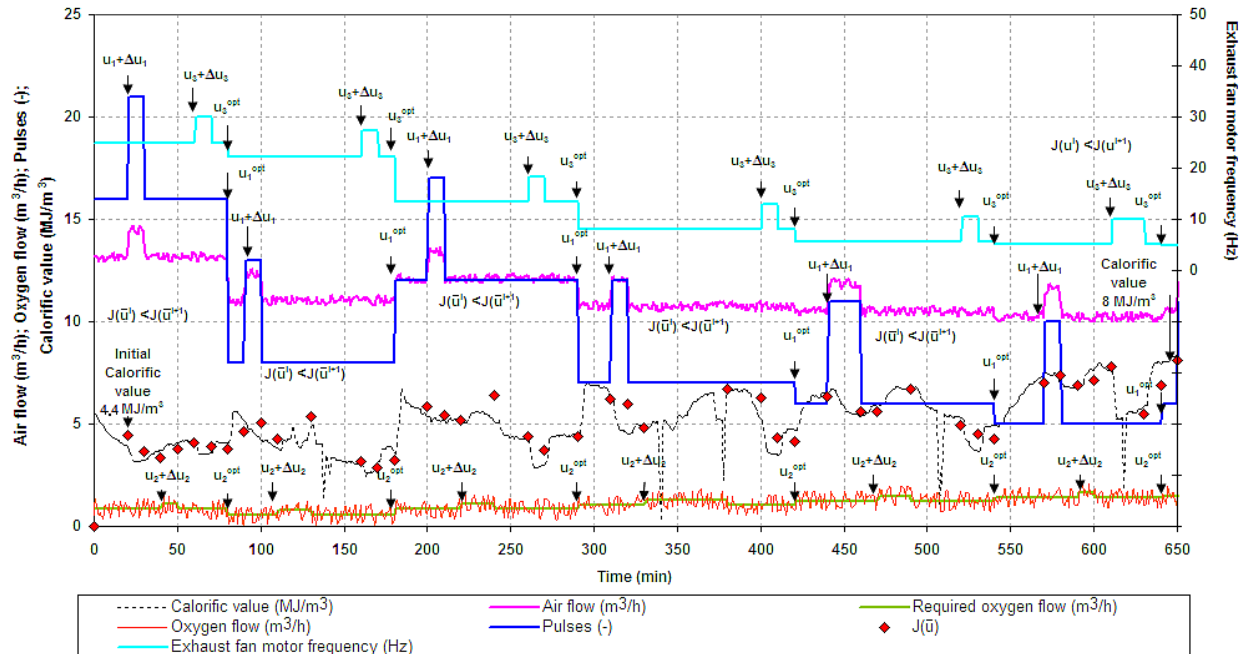
Figure 12. The second test of optimal control with optimization of three parameters.